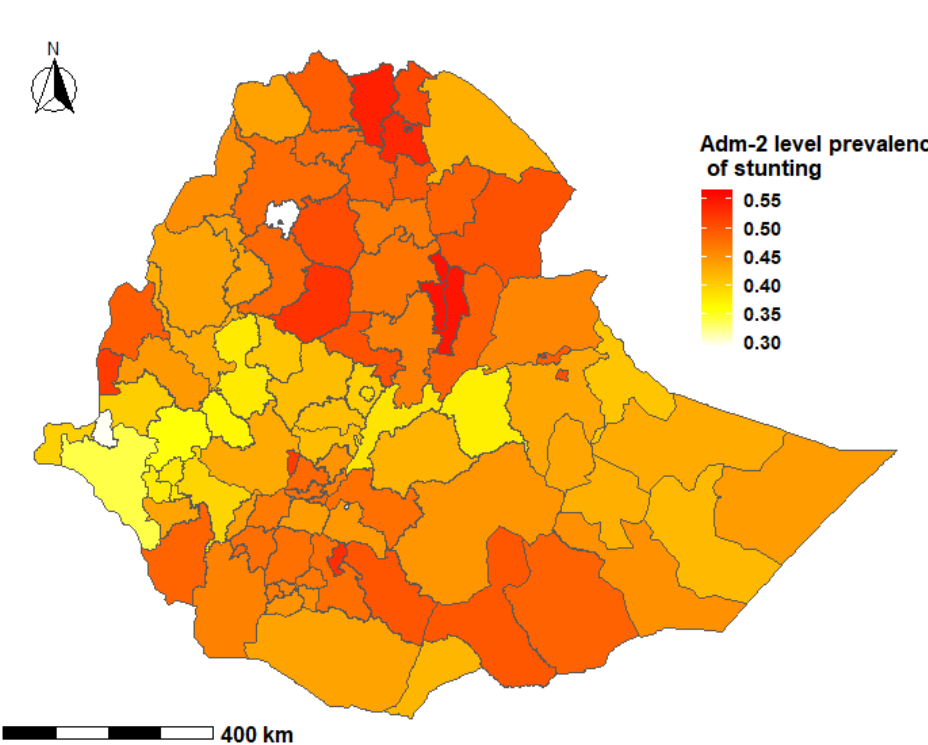
Figure 5. Second administrative level prevalence of stunting among children 24–59 months of age in Ethiopia, EDHS 2016.